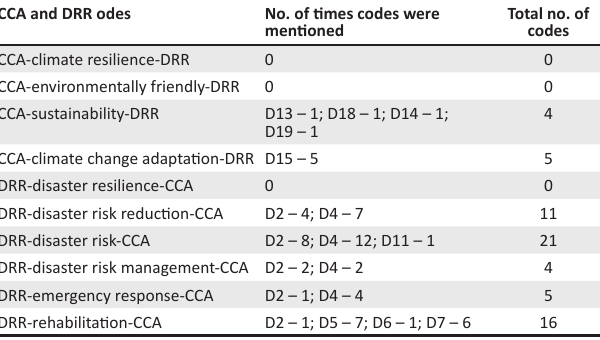
TABLE 3: Interlinkages between climate change adaptation and disaster risk reduction policy and legislations. CCA and DRR odes